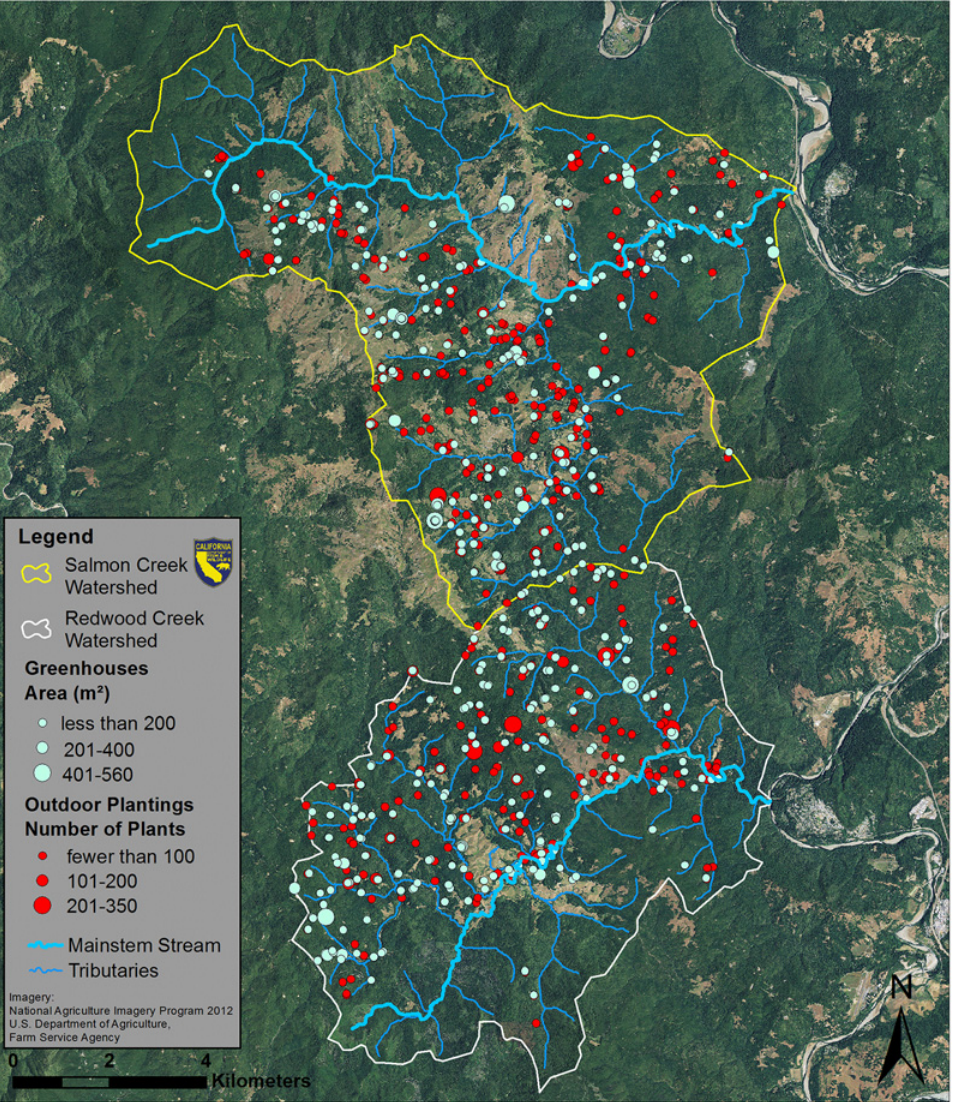
Fig 3. Salmon Creek and Redwood Creek South Watersheds. Outdoor marijuana plantings are marked in red and greenhouses are marked in light